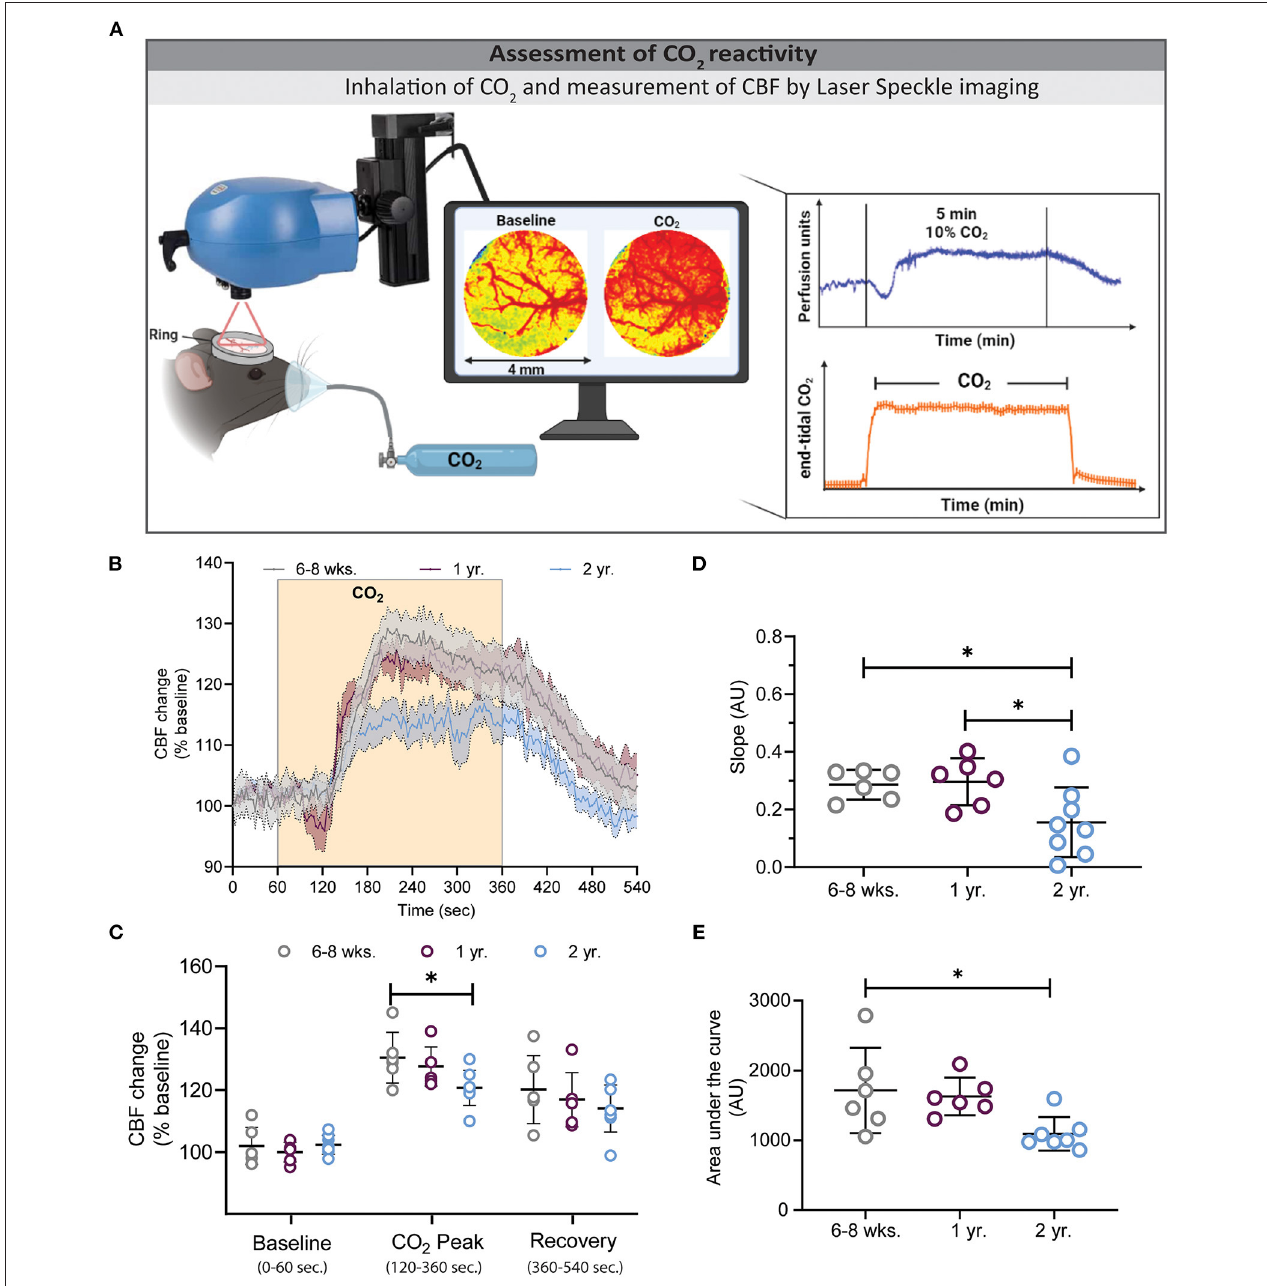
FIGURE 2 | Assessment of CO 2 reactivity using laser speckle contrast imaging (LSCI). (A) Experimental setup of the CO 2 challenge (left) and exemplary traces for LSCI perfusion (top right) and end-tidal CO 2 (bottom right). (B) CBF changes before, during, and after hypercapnia in the three investigated age groups. Two-year-old mice showed a low (C) and slow (D) CBF increase during hypercapnia, whereas young and 1-year-old mice had higher peak values (* P < 0.05: 6–8 weeks vs. 2 year), and faster slope changes (* P < 0.05: 6–8 weeks vs. 2 year and 1 year vs. 2 year). (E) Quantification of the area under the curve (AUC) of graph B depicts smaller AUC in 2 year old mice in comparison to 6–8 weeks and 1 year old mice (* P < 0.05) (mean ± SEM, n = 6–8 mice/group, One-way ANOVA).